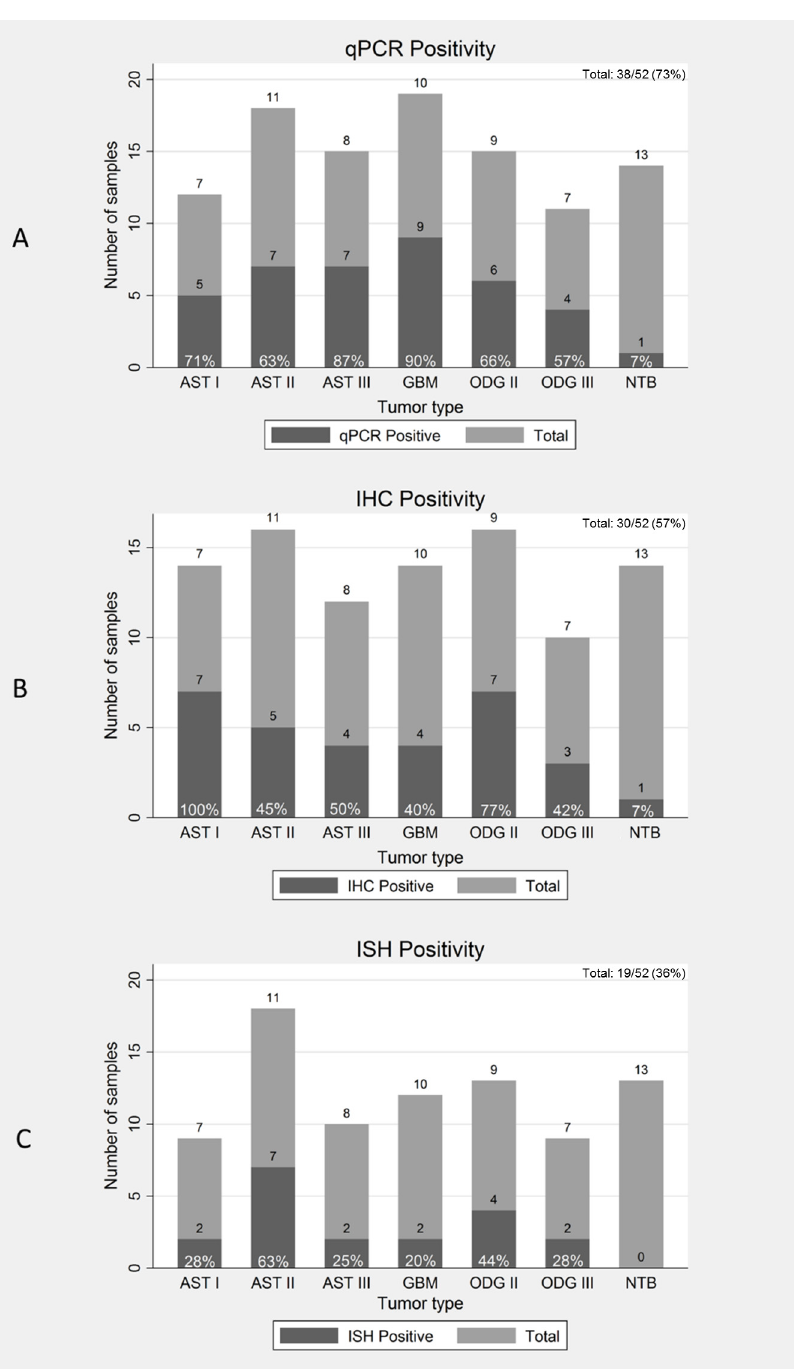
Fig 1. Human Cytomegalovirus positivity in gliomas. Total samples (Light gray), positive samples (Dark gray) and frequency of positivity are shown for astrocytomas (AST I, AST II, AST III and GBM), oligodendrogliomas (ODG II and ODG III) and non-tumoral brain (NTB) by qPCR (1A), IHC (1B)and ISH (1C).